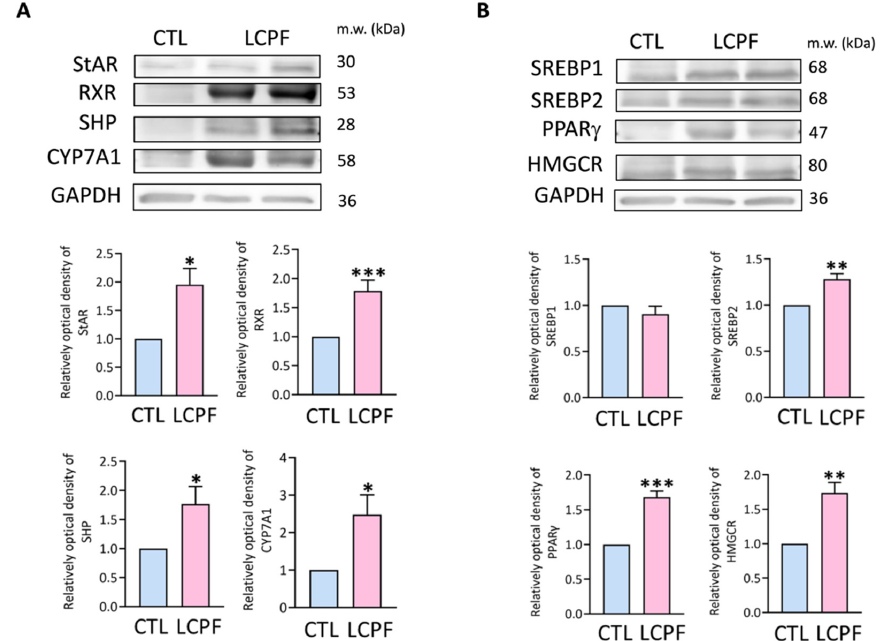
Figure 2. Upregulation of bile acid synthesis and cholesterol metabolism protein by LCPF stimulation. HUVECs were incubated with LCPF or control medium for 24 h. ( A ) Proteins regulating bile acid synthesis, such as steroidogenic acute regulatory protein (StAR), RXR, SHP, and CYP7A1, were examined by Western blotting. GAPDH was used as an internal control. ( B ) Proteins responsible for cholesterol metabolism were analyzed including sterol regulatory element binding protein 1 (SREBP1), SREBP2, peroxisome proliferator-activated receptor gamma (PPAR- γ ), and HMG-CoA reductase (HMGCR). GAPDH was used as an internal control. * p < 0.05; ** p < 0.01; *** p < 0.001, compared to the control group. Original blots are shown in Figure S3